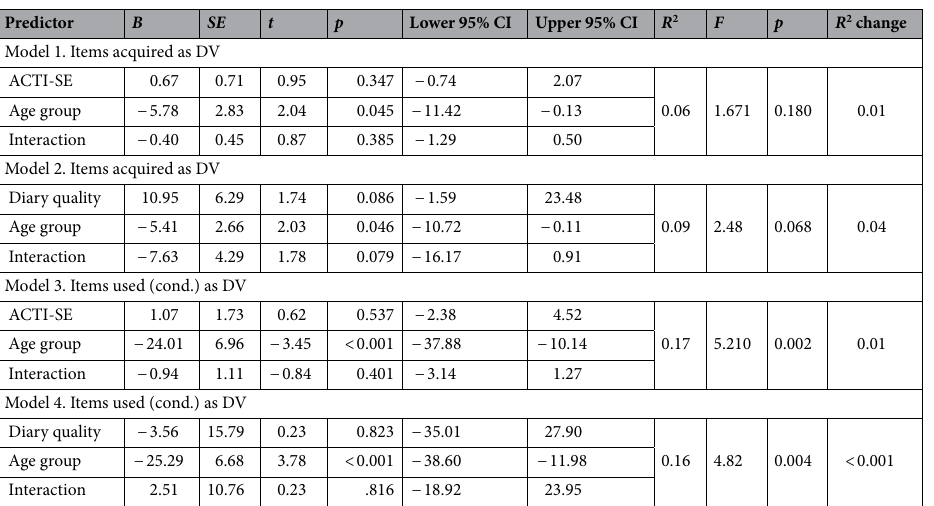
Table 3. Results of moderated regression analyses for each episodic foresight outcome. Degrees of freedom for F statistic = 3, 76. ACTI-SE actigraphy assessed sleep efficiency. Items acquired = percentage of correct items acquired. Items used (cond.) = the proportion of items used to items acquired.